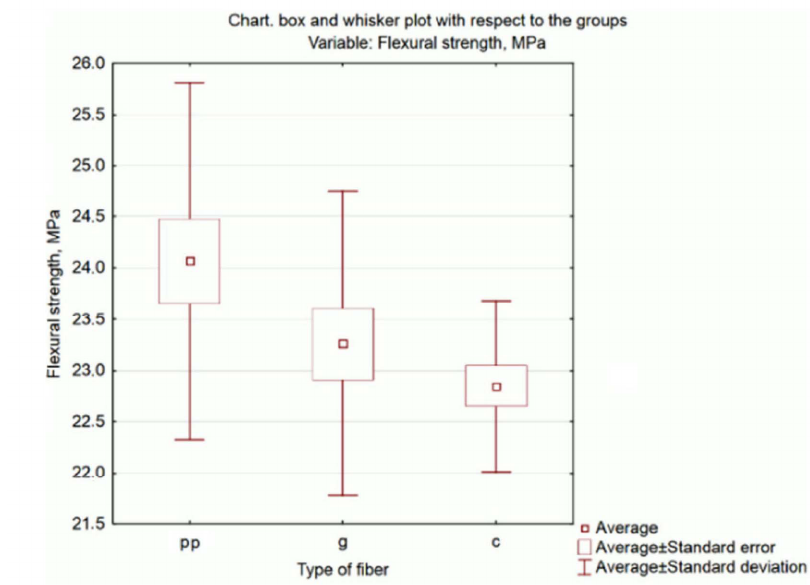
Figure 5. Box and whisker plot of flexural strength related to the type of